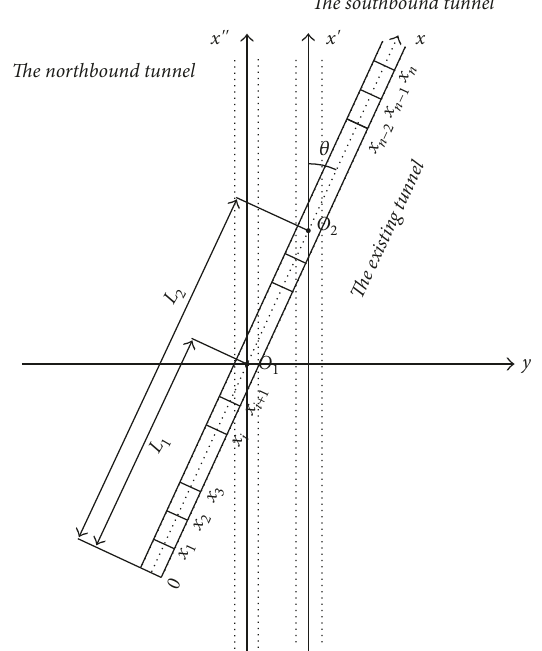
Figure 14: A schematic diagram of tunnels for the analytical